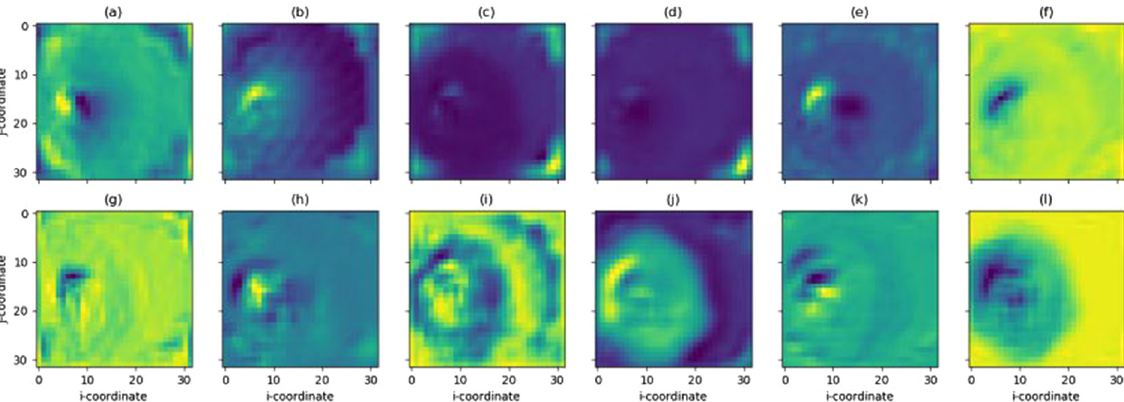
Fig. 4. Sample of 12 learnt feature-maps from the output of fi rst dense block for the input of vibrating fuel assembly at (8,16) given all possible detectors. Visually depicting how the differing layers highlight different features of the image. (a) Shows a peak at the source of vibration, (d) the response on the core barrel, (j) the noise dissipating throughout